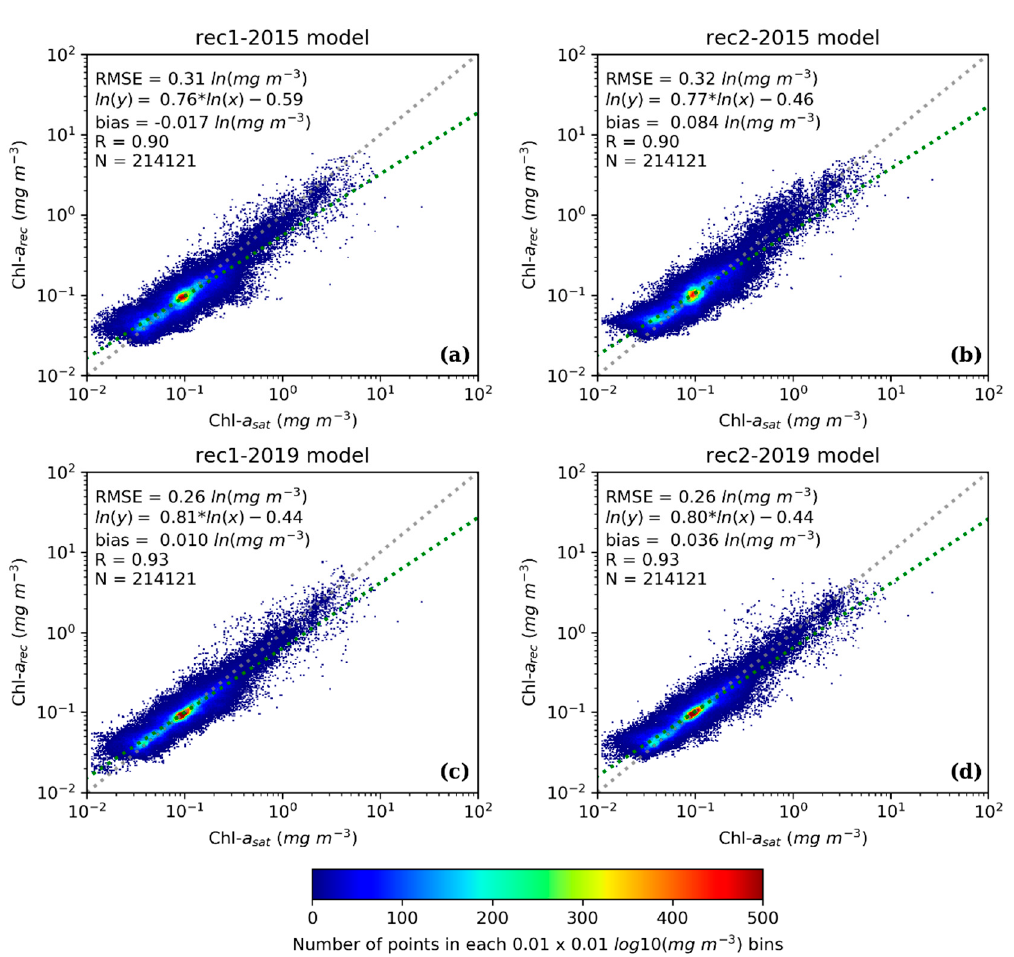
Figure 14. Scatterplots of the cross-validation data (Chl- a sat ) versus the corresponding modeled data (Chl- a rec ), where the Chl- a sat ranged from 2019.1 to 2019.10. ( a ) Chl- a rec reconstructed by the rec1-2015 model; ( b ) Chl- a rec reconstructed by the rec2-2015 model; ( c ) Chl- a rec reconstructed by the rec1-2019 model; ( d ) Chl- a rec reconstructed by the rec2-2019 model. The color scale indicates the number of points in each 0.01 * 0.01 log10 (mg m − 3 ) bin. Green dotted lines show the best fit line and grey dotted lines represent the 1:1 line.